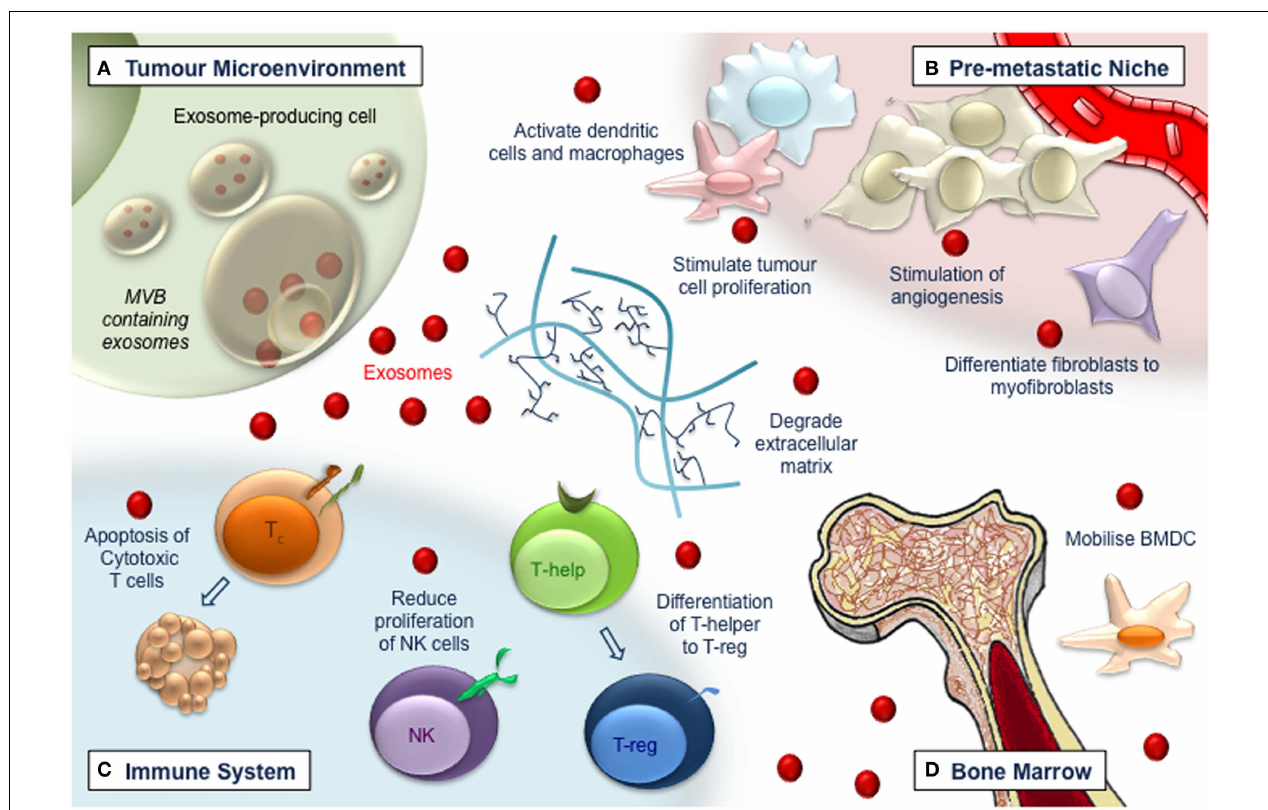
to a pro-tumor environment. (C) Immune responses become deregulated in a manner that impedes tumor recognition and anti-tumor immune functions. CytotoxicT-cells are induced to apoptose, while NK cell proliferation is impaired andT-helper cells differentiate toward aT-regulatory cell phenotype. (D) Bone-marrow-derived cells are recruited to tumor and pre-tumor tissue where they contribute to cancer